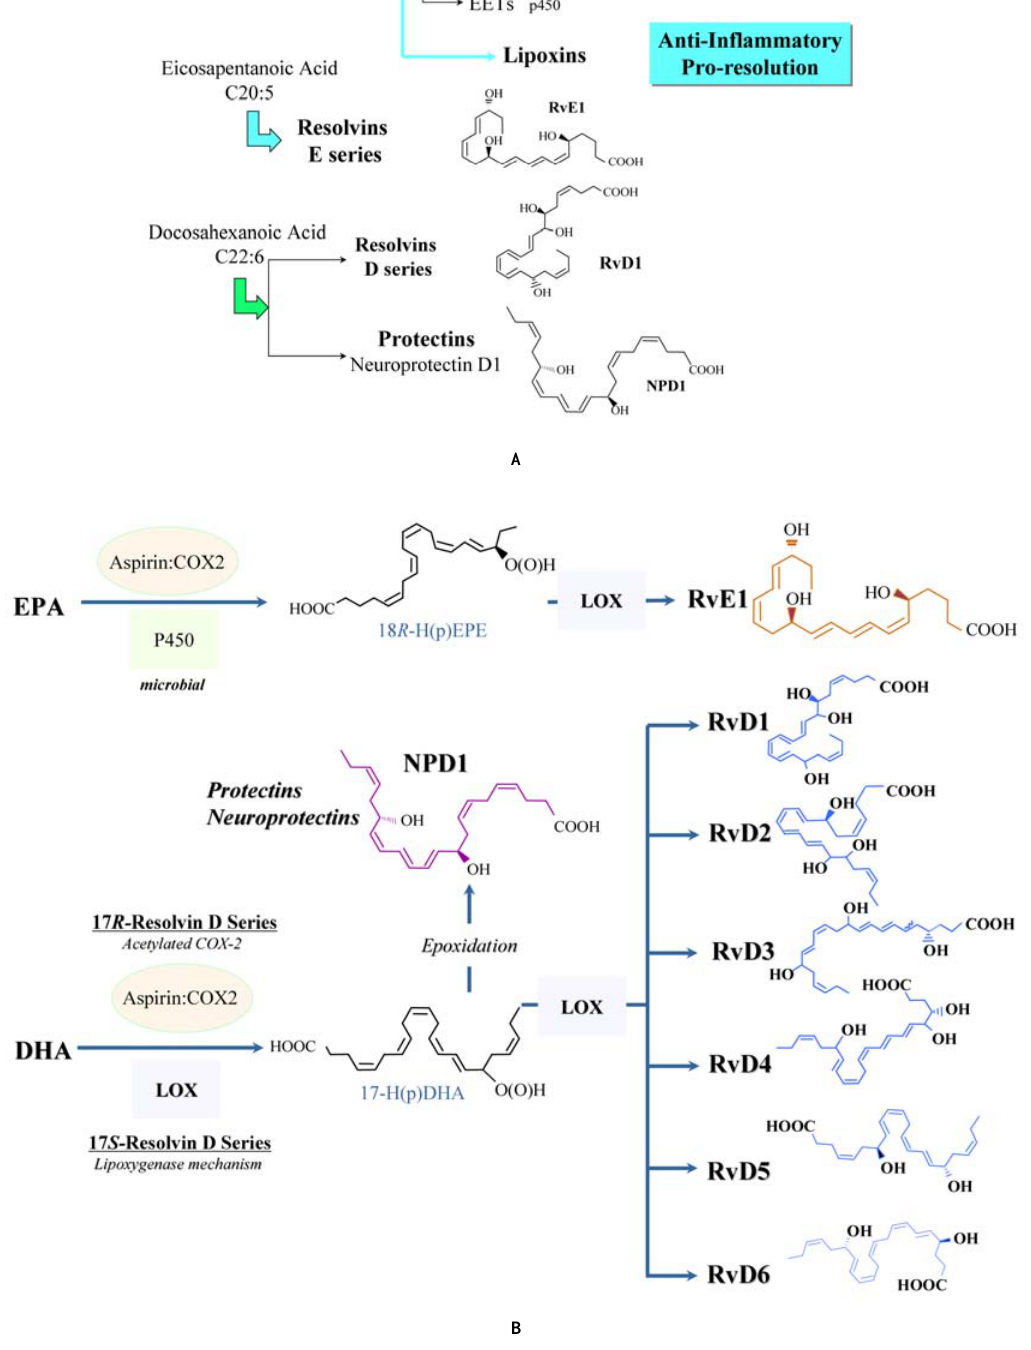
FIGURE 1. (A) Families of bioactive lipid autacoids. Arachidonic acid is the precursor for many of the known bioactive mediators, epoxyeicosatrienoic acids (EETs), prostaglandins, leukotrienes, and lipoxins (both pro- and anti-inflammatory mediators). The omega-3 (polyunsaturated fatty acids) PUFA, EPA (C22:5) and DHA (C22:6), are precursors to potent new families of mediators termed resolvins and protectins (see text for details). (B) Formation of resolvin E1 derived from EPA, resolvin D1, protectins, and neuroprotectin D1 from